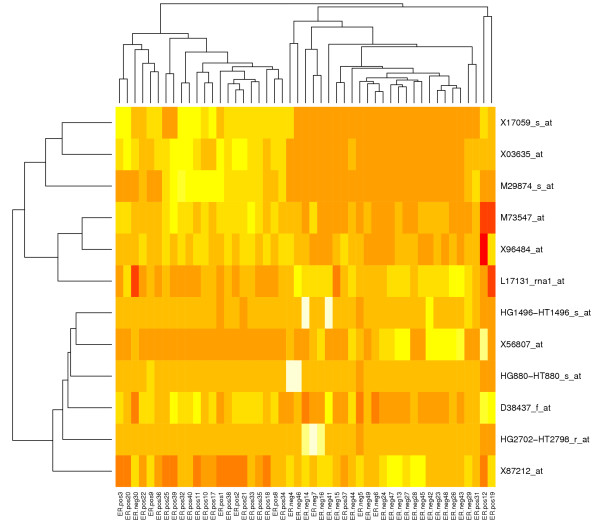
Clustering dendrogram of breast cancer data – Reduced Feature Set.